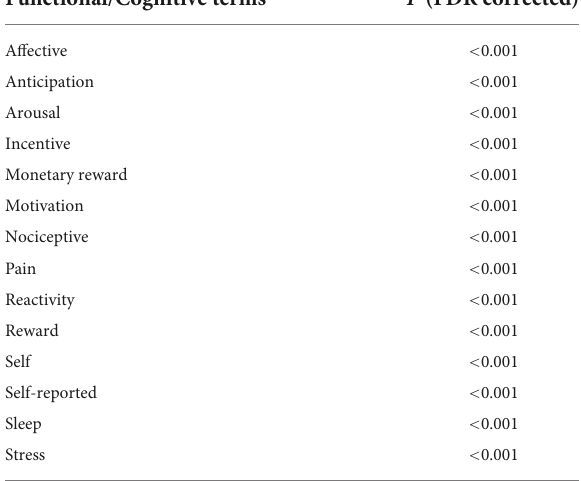
TABLE 3 Functional annotation results. Functional/Cognitive